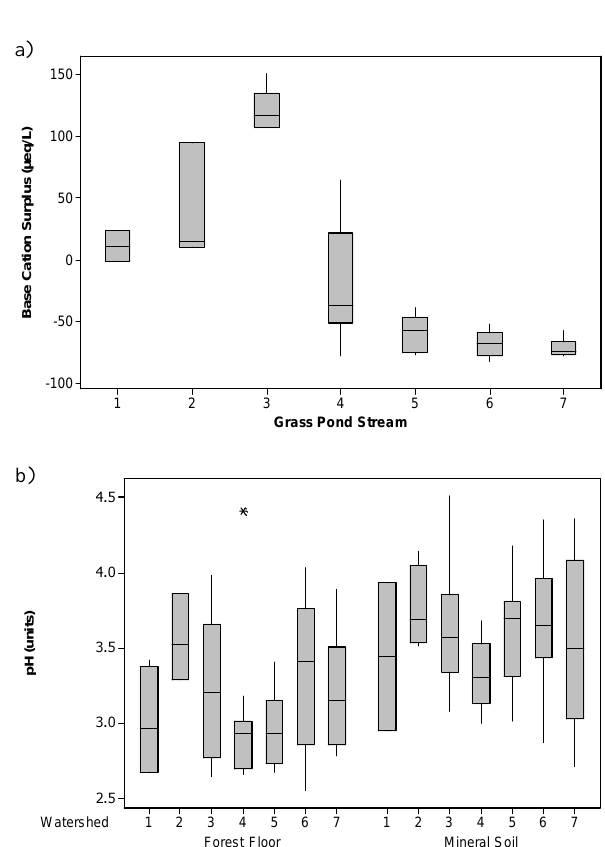
Figure 3. a) Base-cation surplus means (µeq L -1 ) for each Grass Pond stream with bars indicating one standard deviation. Values ≤ 0 µeq L -1 indicate a low capacity to neutralize acidic inputs. b) Forest floor and mineral soil sample pH (units) for each Grass Pond subwatershed.